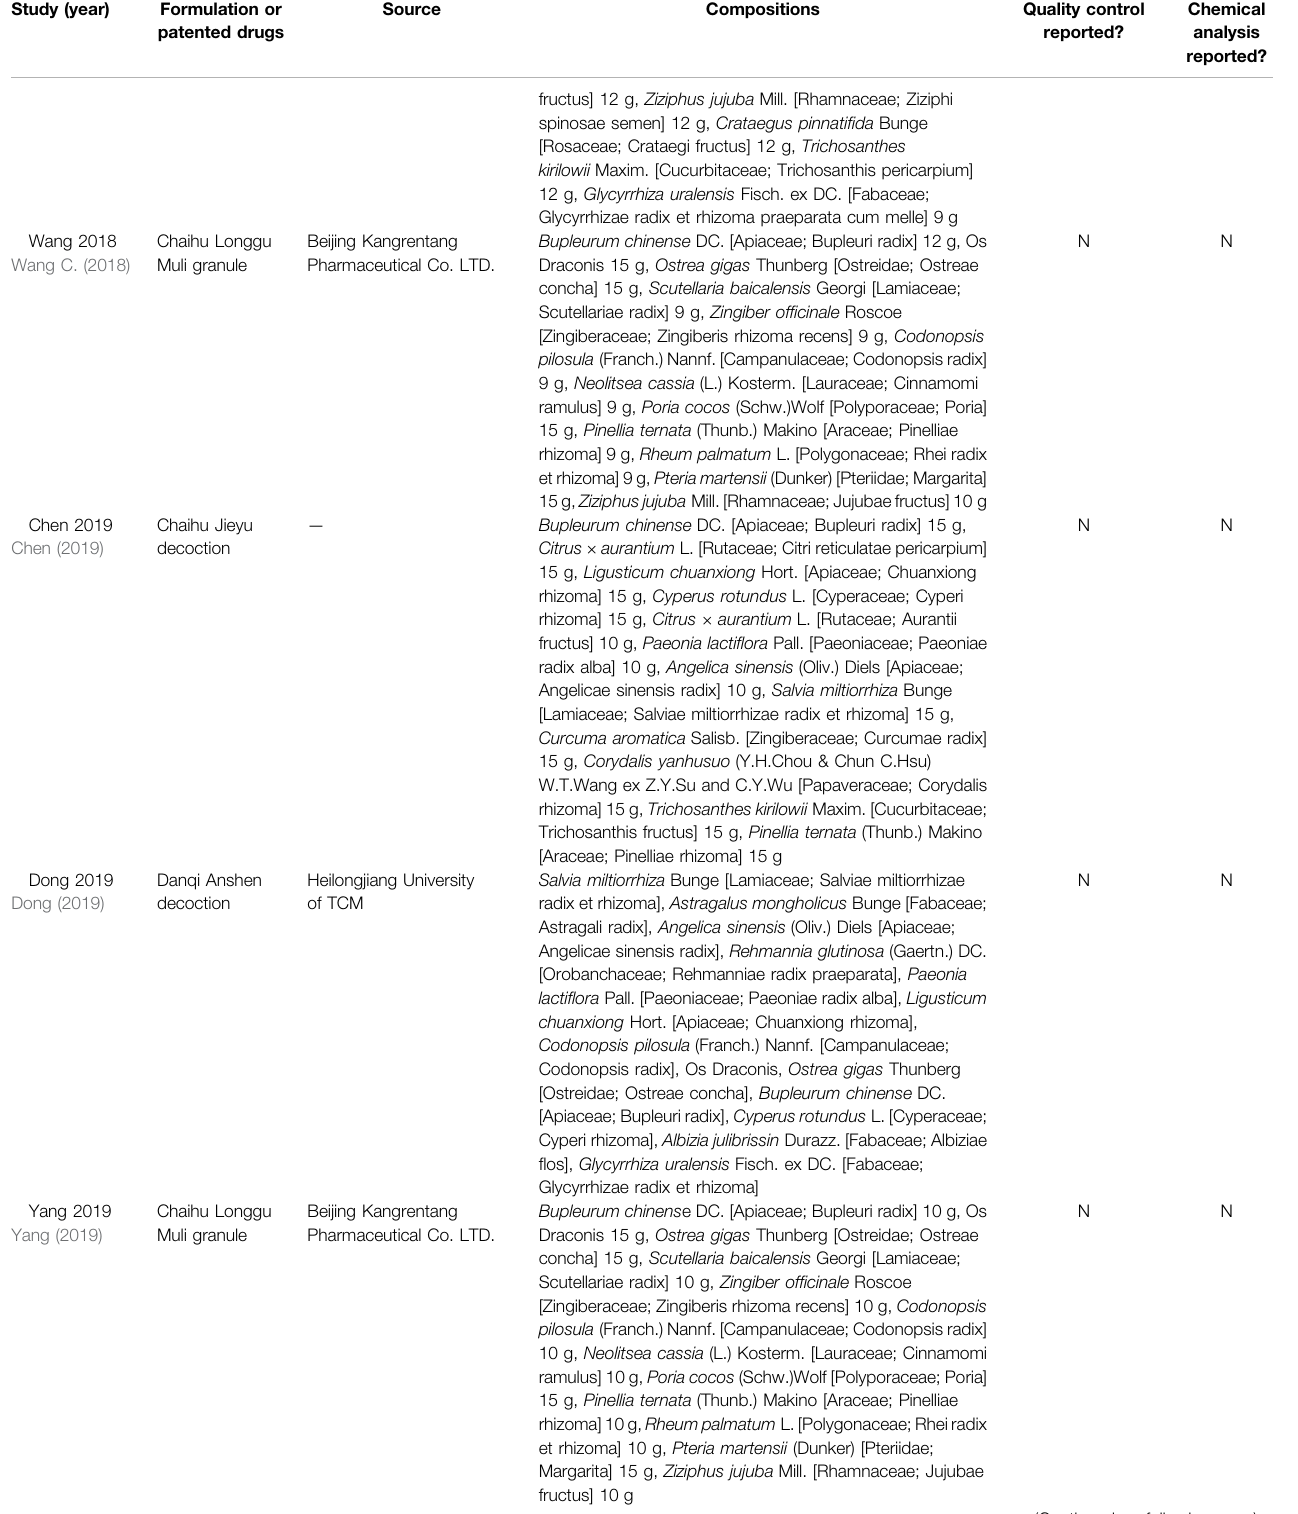
TABLE 1 | ( Continued ) Compositions of formulation and patented